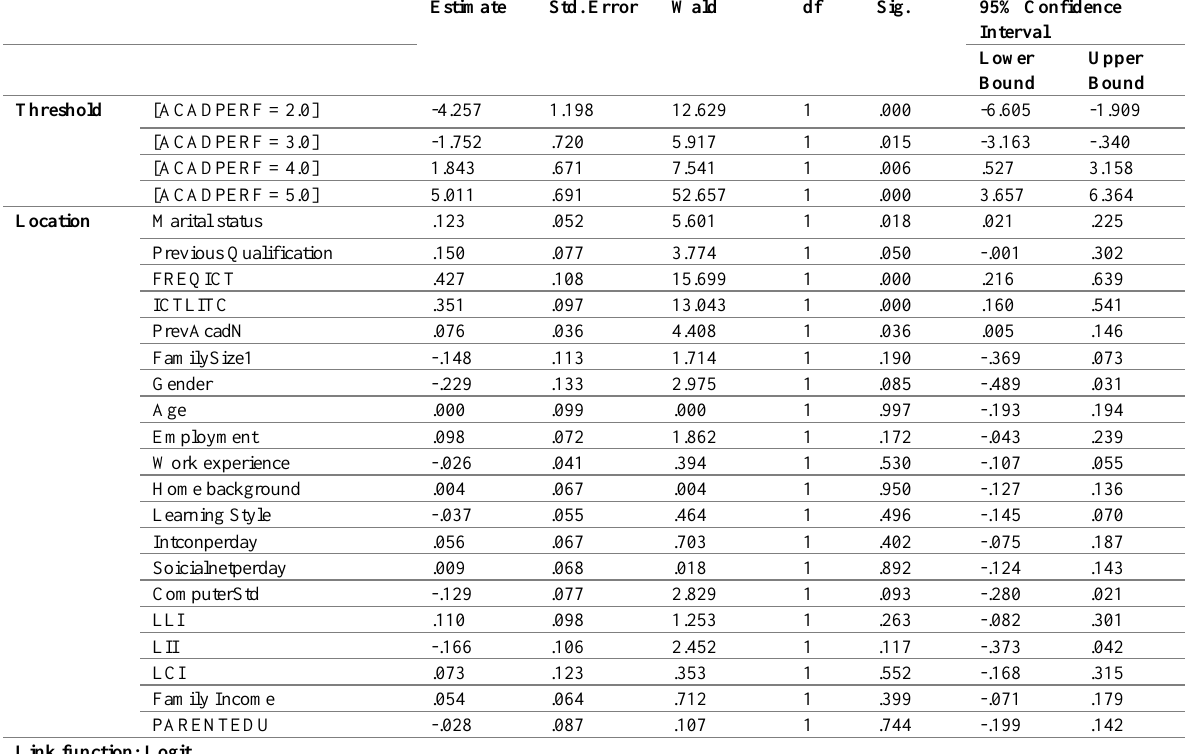
Table 1: Parameter Estimates on Explanatory Variables Associated with Academic Performance of Distance E-Learners Based